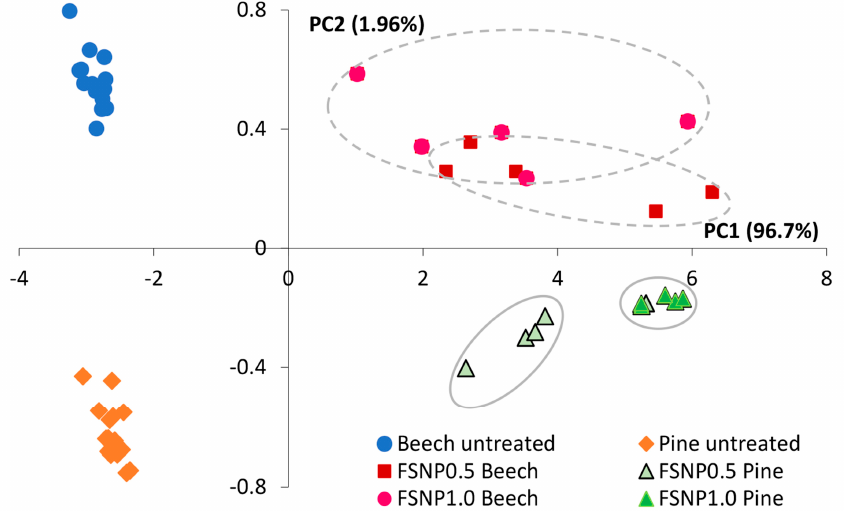
Figure 4. PCA score plot of the untreated and FSNP1.0-modified wood in the 1800–800 cm − 1 spectral region.